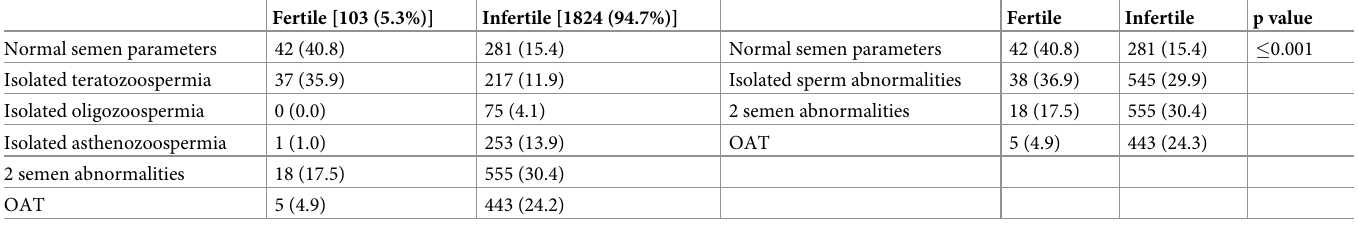
Table 1. Semen characteristics among the whole cohort according to fertility status [No. (%)] (No. = 1927). Fertile [103 (5.3%)] Infertile [1824 (94.7%)] Normal semen